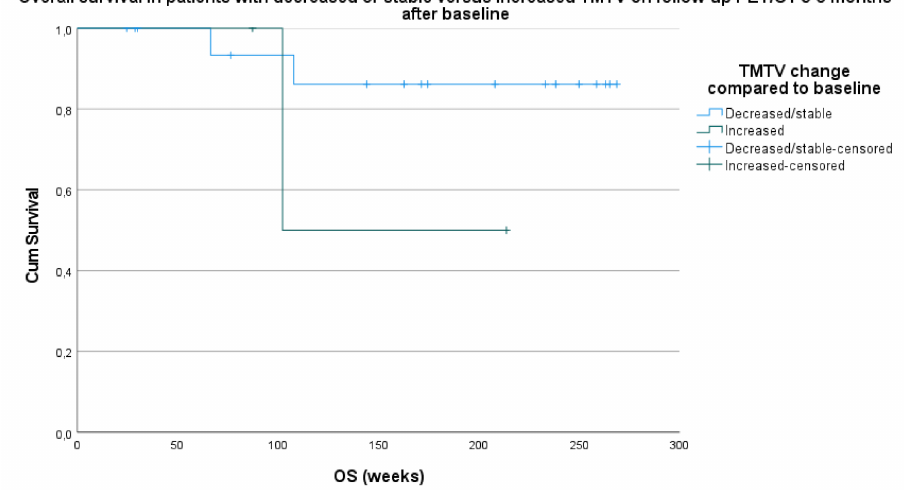
Figure 5. Survival analysis based on overall survival (OS) in patients with stable/decrease in TMTV versus increase in TMTV on follow-up PET/CT 5–6 months after baseline compared to TMTV on baseline